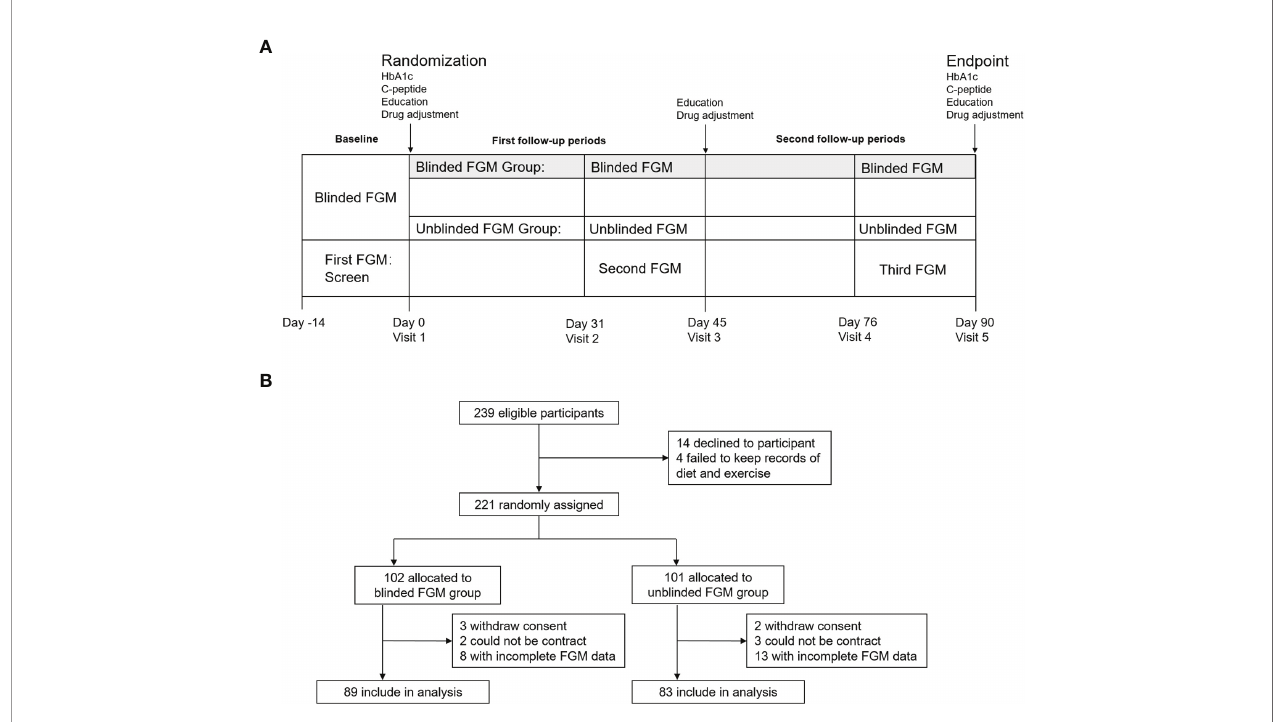
FIGURE 1 | Study design (A) and trial pro fi le (B)